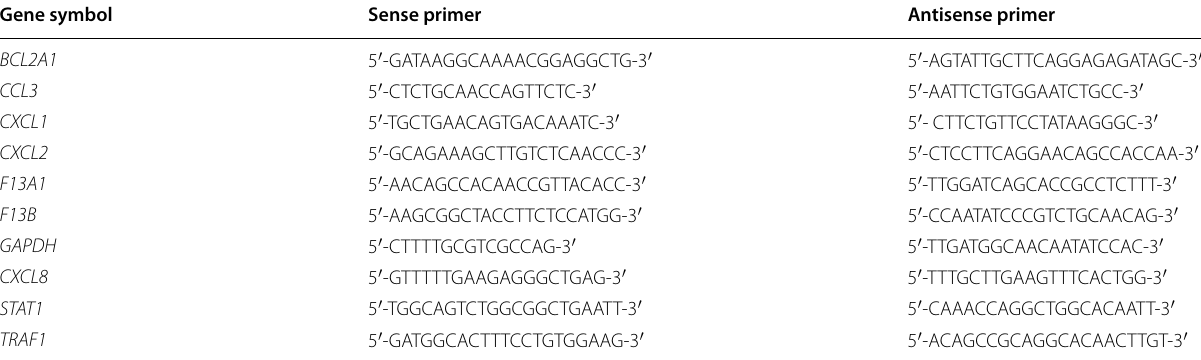
Table 1 Oligonucleotide primers used for real time-polymerase chain reaction Gene